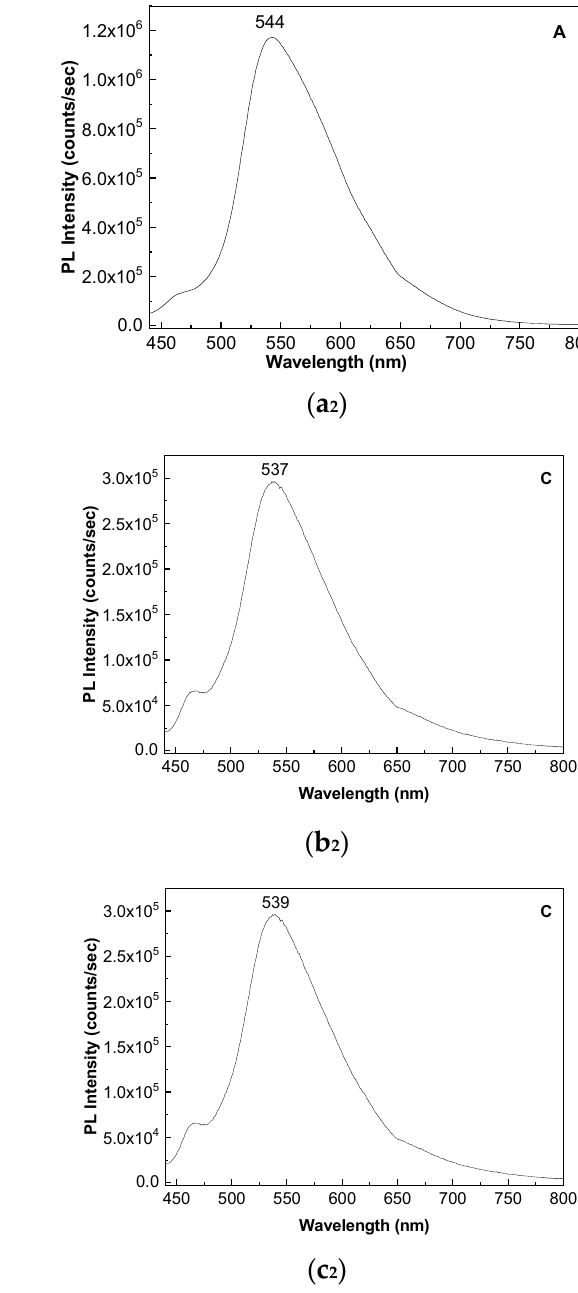
Figure 6. PLE (1) and PL (2) spectra of the POPD-PVDF blends labeled as samples A ( a 1 , a 2 ), B ( b 1 , b 2 ) and C ( c 1 , c 2 ), recorded at the emission wavelength of 600 nm and the excitation wavelength of 420 nm, respectively. at the emission wavelength of 600 nm and the excitation wavelength of 420 nm,